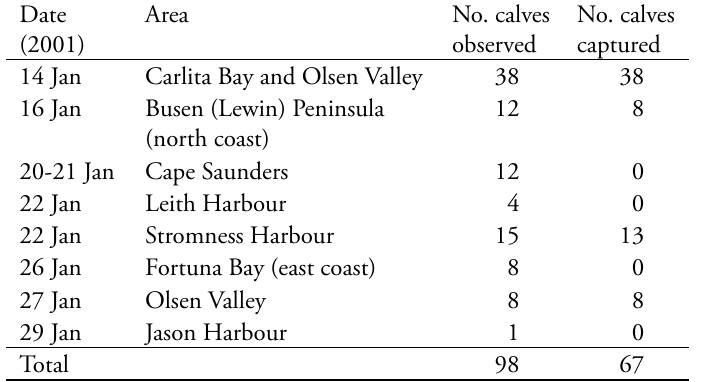
Table 2. Date (2001) and location where calves were observed and cap- tured on South